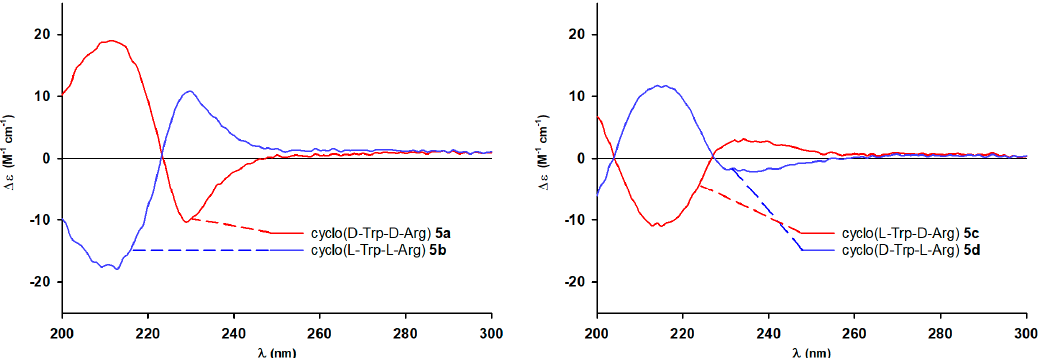
Figure 2. Electronic circular dichroism spectra observed for diketopiperazines 5a and 5b (left) and 5c and 5d (right).